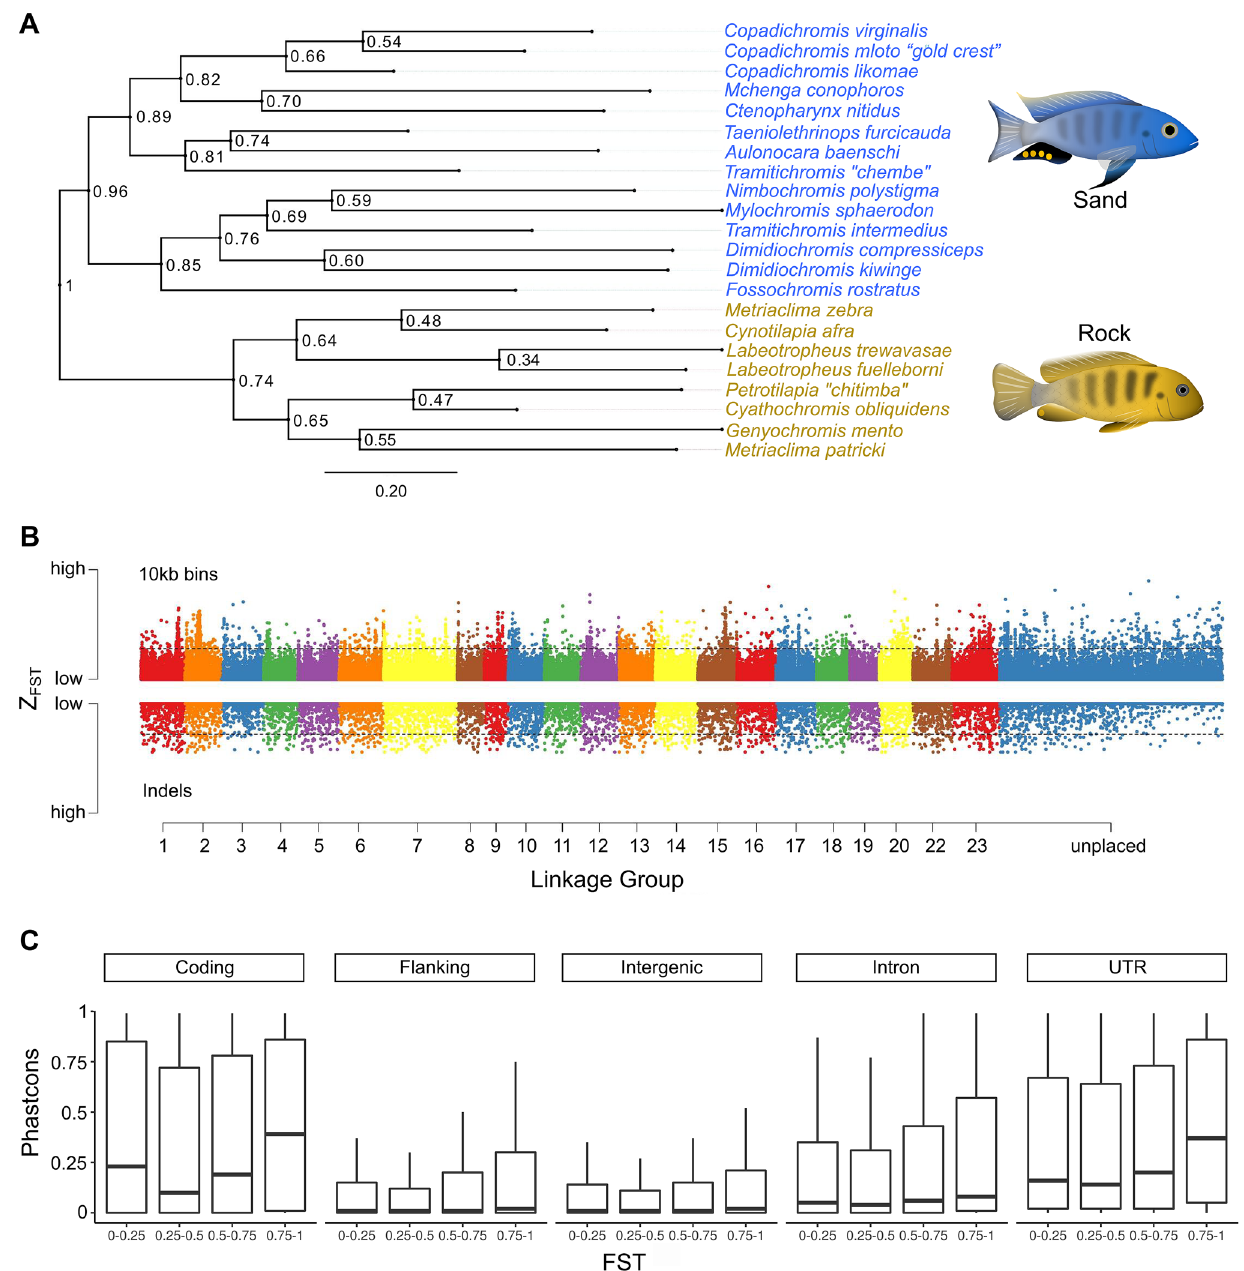
Figure 1. The genomic substrate for rock vs. sand evolution. ( A ) A maximum likelihood phylogeny of eight rock- and 14 sand-dwelling species, based on variable sites (informative SNP and InDels) identified throughout the genome. “Sand” species contain representatives of the lineages “shallow benthic, deep benthic and utaka” from Ref. 32 , while the “rock” species correspond to the “mbuna” lineage. ( B ) A plot of Z-F ST (F ST normalized using Fisher’s Z-transformation) across the genome (ggplot2 v3.3.3https:// ggplo t2. tidyv erse. org/), plotting genomic divergence between rock- vs. sand-dwelling groups. Single nucleotide polymorphisms (SNPs) summed over 10 kb bins and insertion-deletion mutations (InDels) are shown on the same scale. Numbers along the x-axis refer to linkage groups (i.e., chromosomes) and threshold lines indicate 2.5% FDR. ( C ) Evolutionary conservation (PhastCons) scores were calculated for each nucleotide across the genome, subdivided by genome annotation and plotted by bins of increasing F ST . The PhastCons score for each genome category is significantly higher for increasing bins of F ST (pairwise Wilcoxon rank sum p value < 2e−16 for each pair of